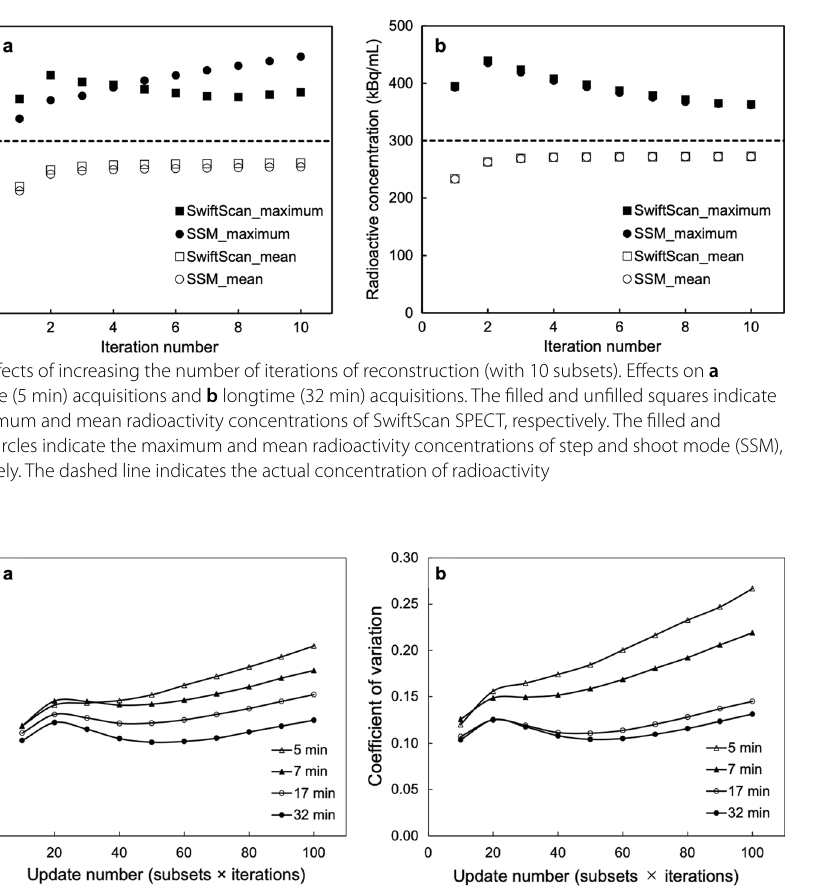
Fig. 4 Relationship between update number and coefficient of variation (CV). CV of various acquisition times using a SwiftScan SPECT and b step and shoot mode (SSM). The update number is the product of the subset and